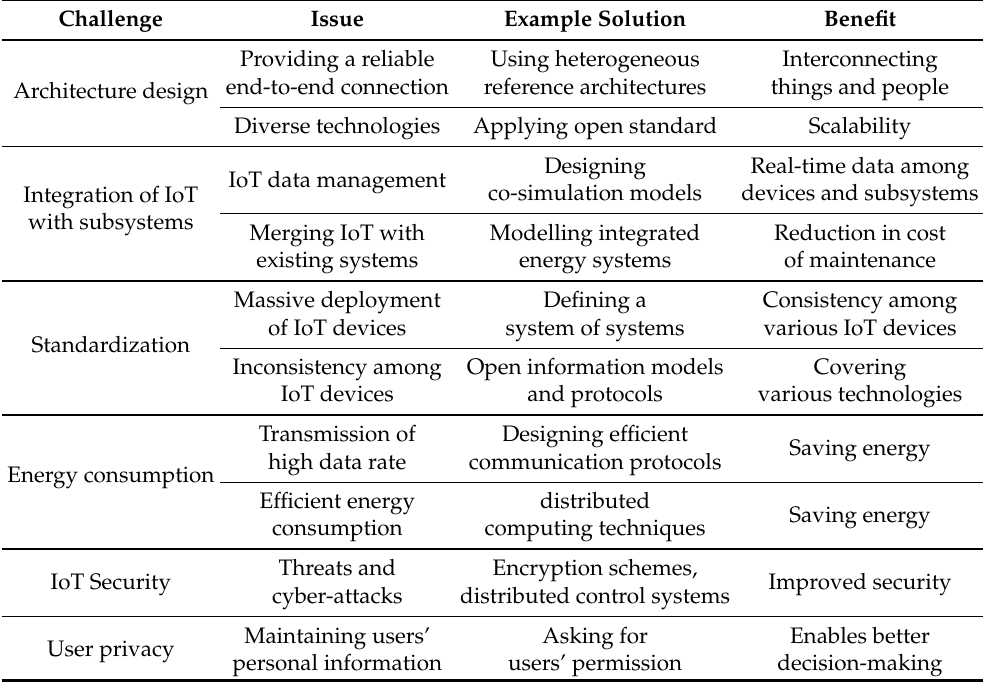
Table 4. Challenges and current solutions of using IoT in the energy